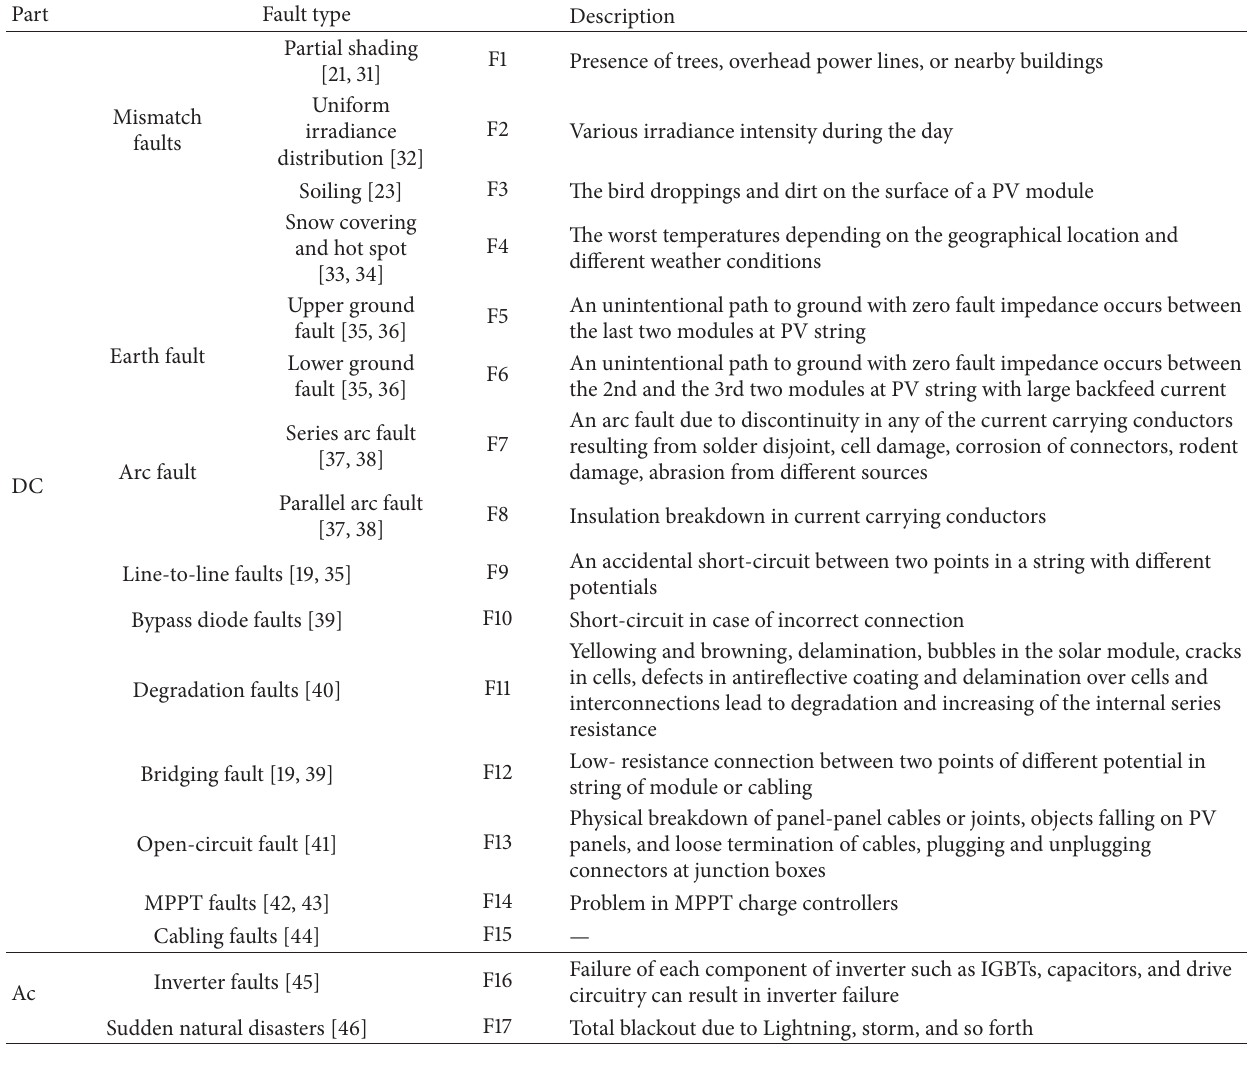
Table 1: Classification and definition of faults in PV system based on location and structures.